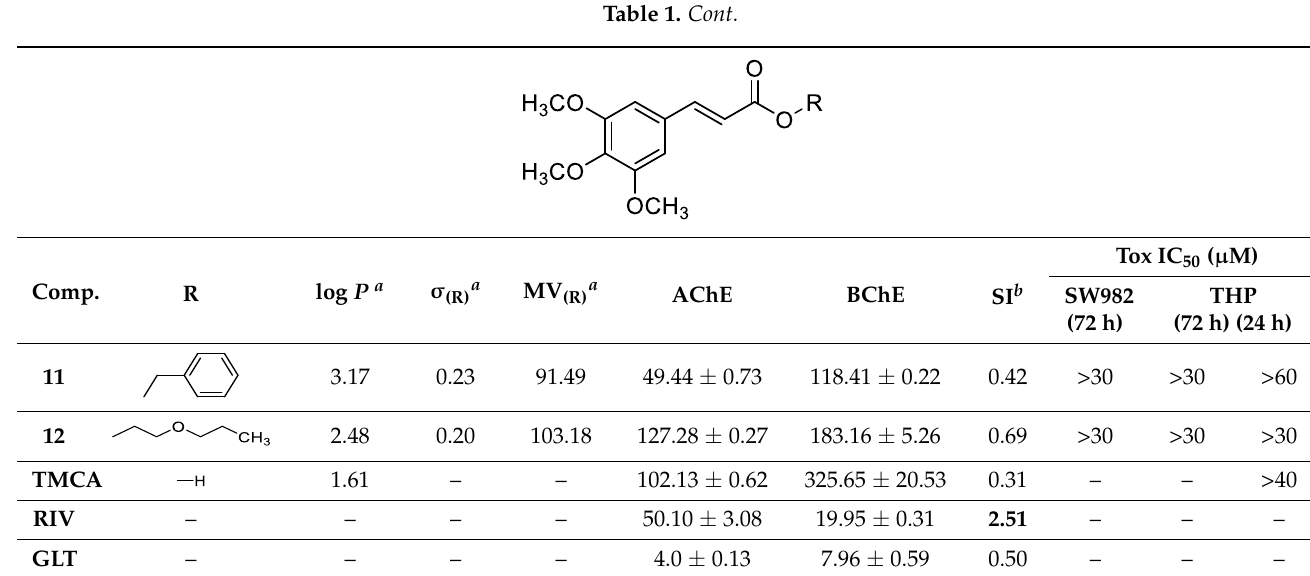
Table 1. Structures of 3,4,5-trimethoxycinnamic acid (TMCA) and its discussed ring-substituted esters 1 – 12 ; calculated values of log P , electronic σ parameters of R substituents and molar volume (MV (cm 3 )) of R substituents; in vitro AChE and BChE inhibition (IC 50 ( μM )) compared with standards rivastigmine (RIV) and galantamine (GLT) and in vitro viability (SW982, THP1- Blue™ NF - κB) assays (IC 50 ( μM ) after 24 h and 72 h incubation) of investigated compounds. Cholinesterase